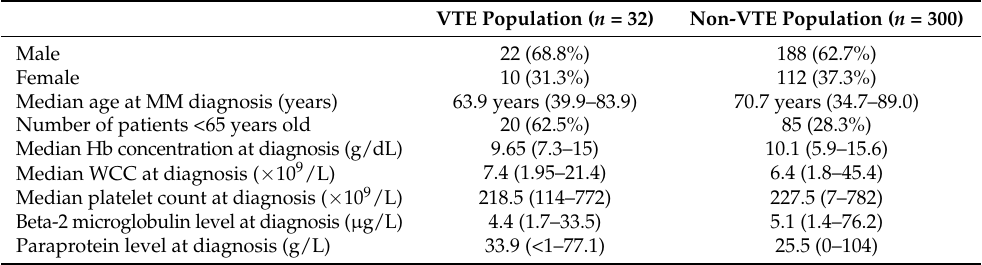
Table 2. Baseline characteristics of the VTE and non-VTE populations. Hb = haemoglobin. WCC = white cell count.